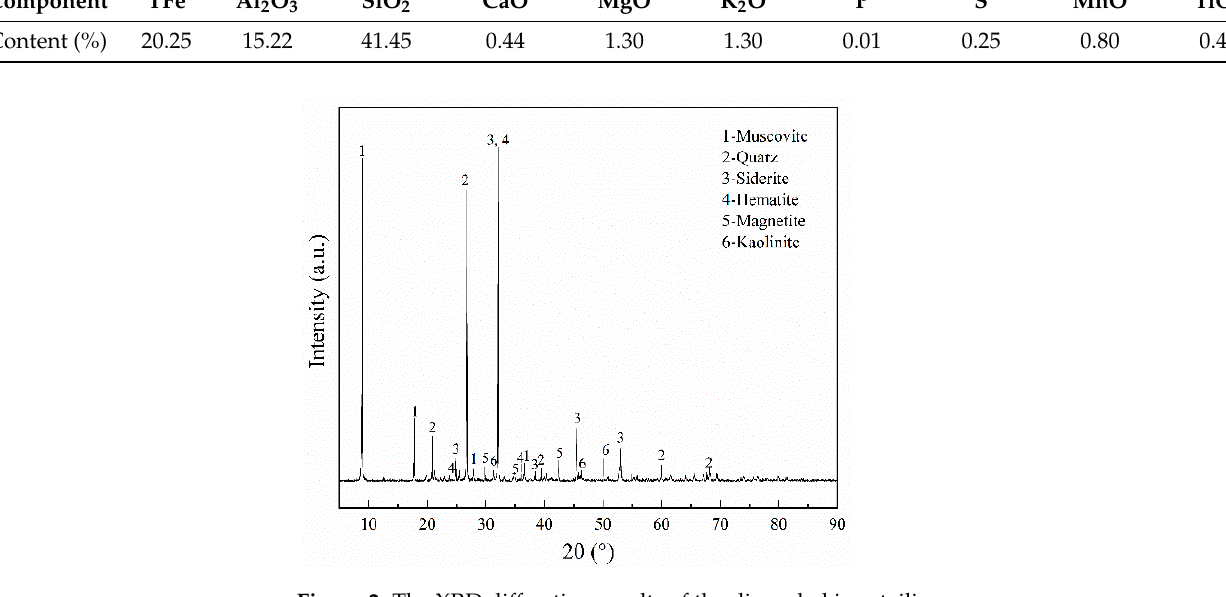
Figure 2. The XRD diffraction results of the discarded iron tailings.